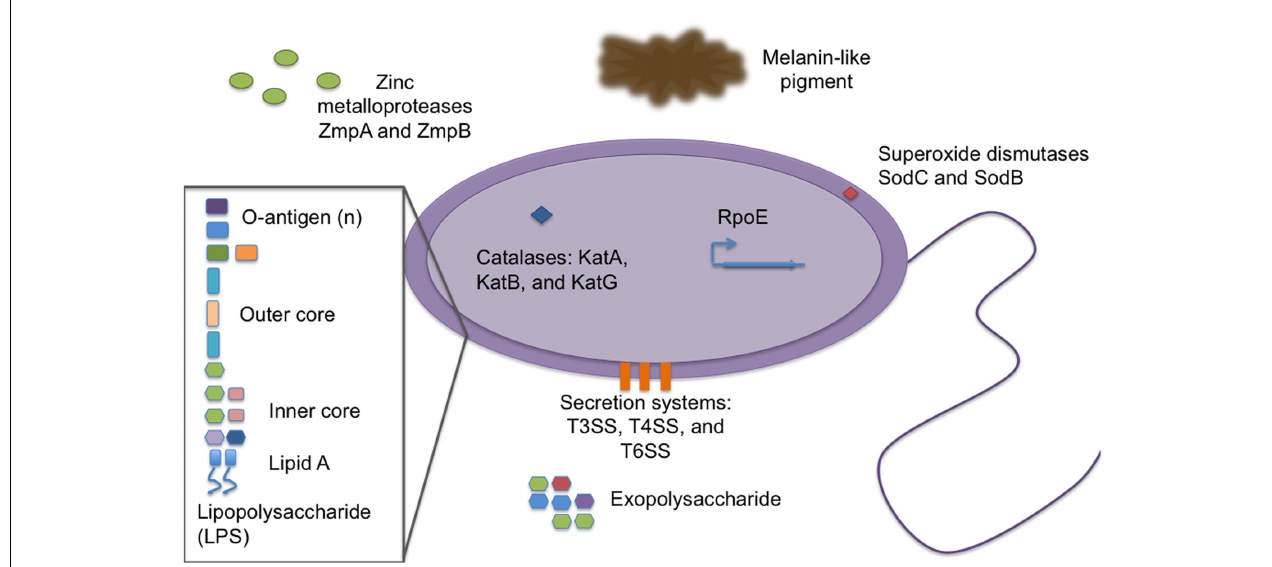
FIGURE 1 | Burkholderia cepacia complex virulence factors important for survival in interactions with host phagocytes. Representation of known virulence factors utilized by members of Bcc in order to persist when confronting host phagocytes.The description and evidence in support of the roles of these factors is described in the